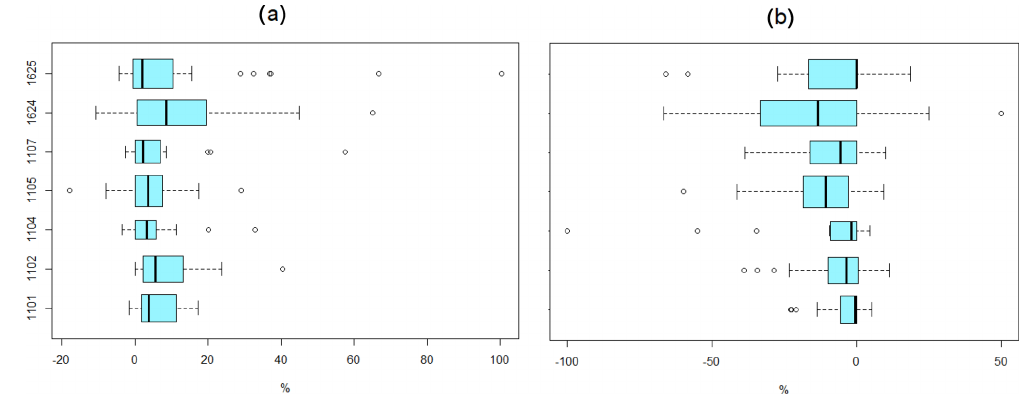
Figure 8. Difference between measured and estimated maximum (a) and minimum (b) instantaneous discharge, 1982–1997.